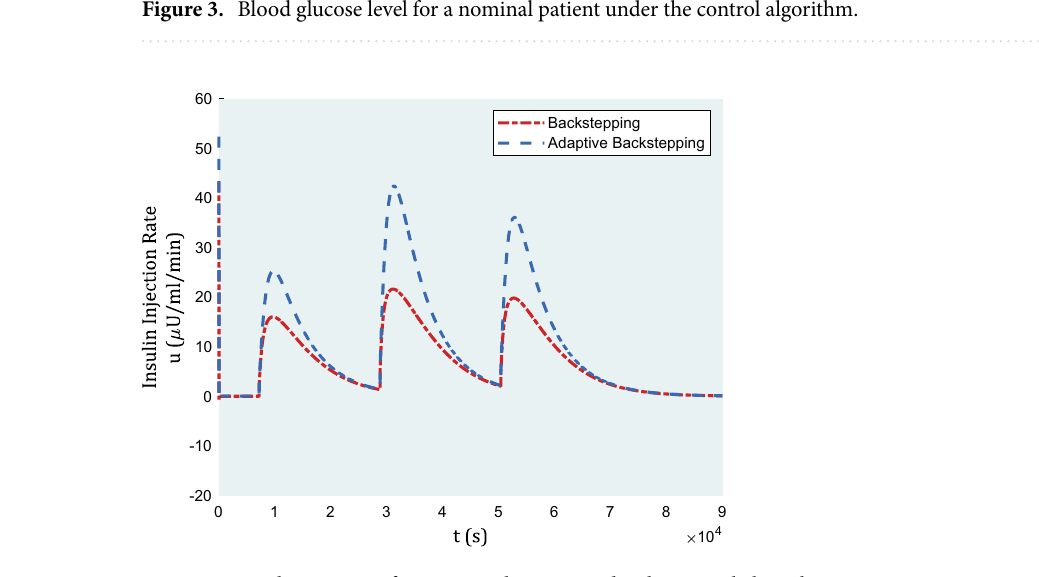
Figure 4. Insulin injection for a nominal patient under the control